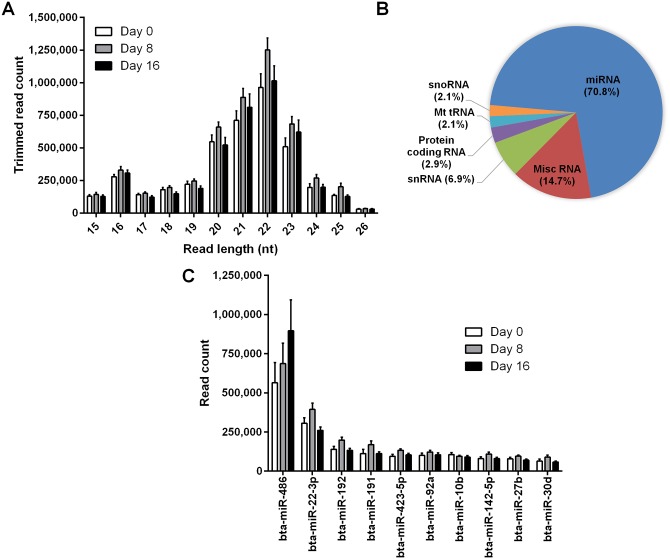
Results of small-RNA sequencing of bovine plasma.(A) Length distribution of trimmed read counts (mean number of reads ± SEM) for each of Days 0, 8 and 16 of the oestrous cycle (n = 8 heifers). (B) Relative abundance (% of total mapped reads) of different RNA species in bovine plasma. The ‘Misc RNA’ category predominantly includes Y RNA, Vault RNA and RNase P RNA. (C) Ten most abundant miRNAs (mean read counts ± SEM) in bovine plasma on each of Days 0, 8 and 16 of the oestrous cycle.